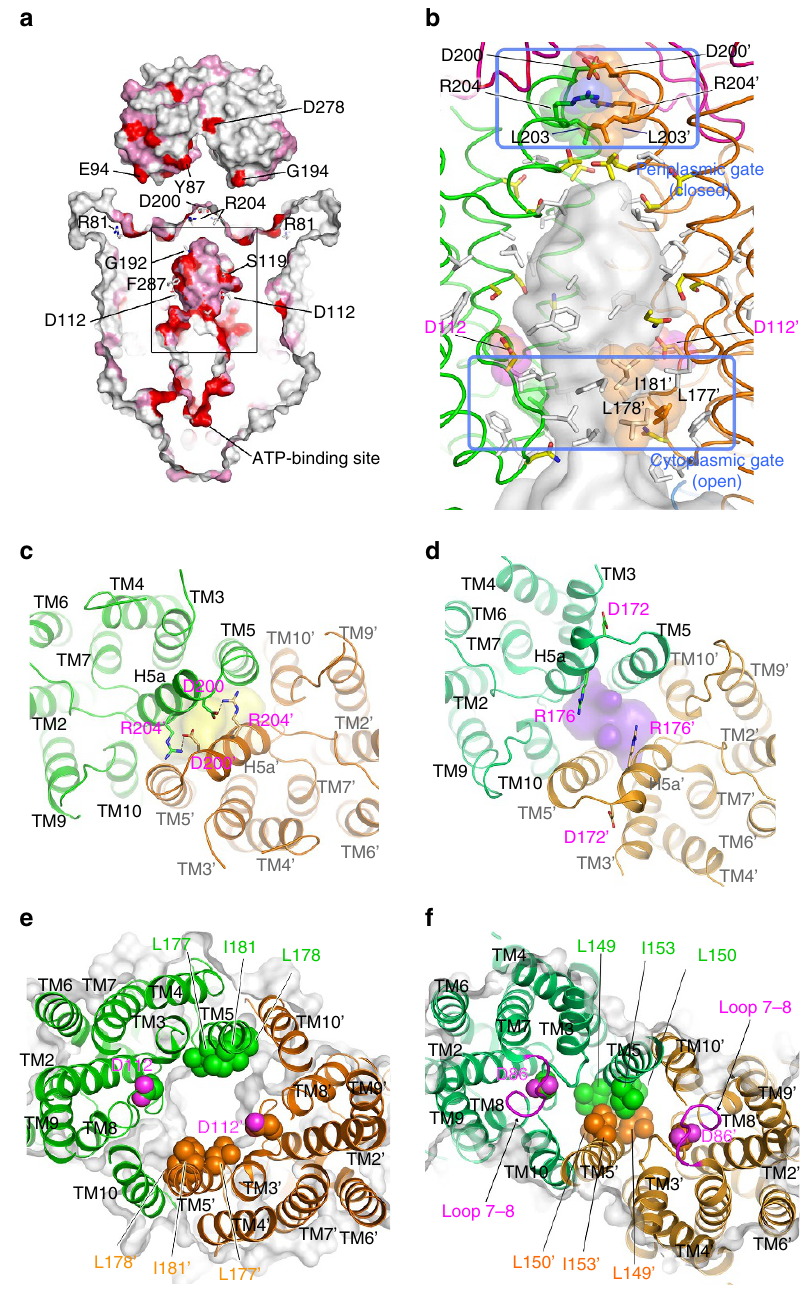
Figure 2 | Residues aligned in the channel of haem transporter. ( a ) Surface representation of conserved (red) and conservatively substituted residues (pink) of BhuUV-Tamong the functionally characterized haem transporters. BhuUV and BhuT are separated for clarity and the conserved residues are labelled. ( b ) Translocation channel of BhuUV-Tcreated by hydrophobic (white sticks) and polar residues (yellow sticks). The periplasmic gate is closed by the interaction between three residues (D200, L203 and R204) of helices H5a. The cytoplasmic gate formed by hydrophobic residues around L177 is open. ( c ) Periplasmic gate of BhuUV-Tviewed from the periplasmic side along the two-fold axis. The gate is completely sealed by interactions of the two H5a helices with the salt bridge between D200 and R204. The long channel at the bottom of H5a and extending to the cytoplasm is shown as a yellow surface. ( d ) Periplasmic gate of HmuUV. The two H5a helices are separated from each other and the cavity (purple surface) is open to the periplasmic side. ( e ) Cytoplasmic gate of BhuUV-T viewed from the periplasmic side. Hydrophobic residues L177, L178 and I181 of TM5 are separated from those of the other monomer to open the cytoplasmic gate. D112 is the only charged residue in the BhuU dimer channel. ( f ) The cytoplasmic gate of HmuU is sealed due to hydrophobic interactions involving L149, L150 and I153 of TM5. D86 corresponds to D112 of BhuU and is buried by the loop residues between TM7 and TM8 solution had a K m of 28 m M and a V max of 5.0 m mol min (cid:2) 1 mg (cid:2) 1 and stimulation by PBP is reported for other type II importers 3,18 , (Supplementary Fig. 4) in the absence of PBP (BhuT). The whereas different ATPase stimulation is reported for type I addition of haem-free BhuT resulted in a 1.4-fold increase in the importers (maltose transporter MalFGK 2 and His permease) 19,20 . V max of BhuUV and K m also increased ( K m of 92 m M, V max of For example, in the maltose transporter, basal activity is observed 7.1 m mol min (cid:2) 1 mg (cid:2) 1 ). A similar level of basal ATPase activity in detergent solution but not in a reconstituted liposome system.